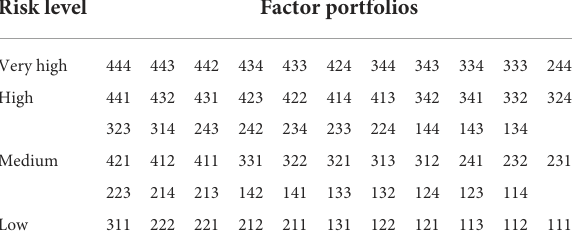
TABLE 3 Factor portfolios of the three-dimensional risk matrix (39,